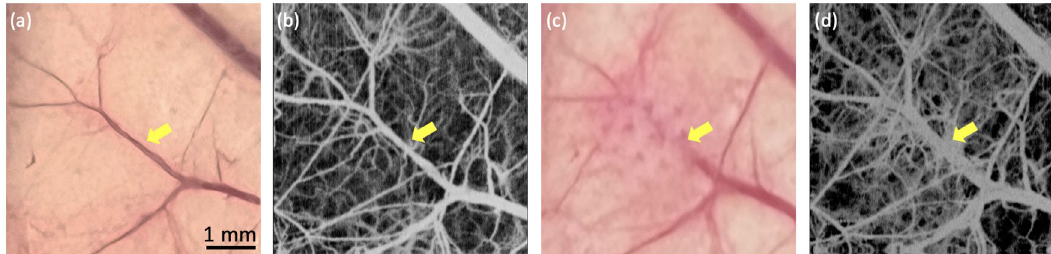
Figure 2. Photo and OCTA images of rabbit ear. ( a , b ) Photo and OCTA image of rabbit ear before PUT. ( c , d ) Photo and OCTA image after PUT.